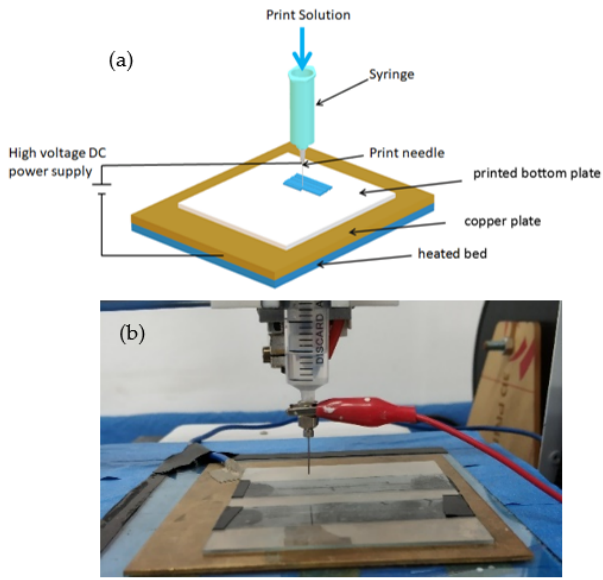
Figure 1. ( a ) Schematic illustration and ( b ) preparation device for printing PVDF/CaCl 2 composite film. After depositing a layer of 20 µ m gold films on the upper and lower surfaces of the PVDF/CaCl 2 composite film as electrodes with a vacuum ion sprayer (MC1000, Hitachi, Kyoto, Japan), a single-layer sensor is formed. A double-layer sensor was obtained by repeatedly printing PVDF/CaCl 2 composite films of the same thickness on the